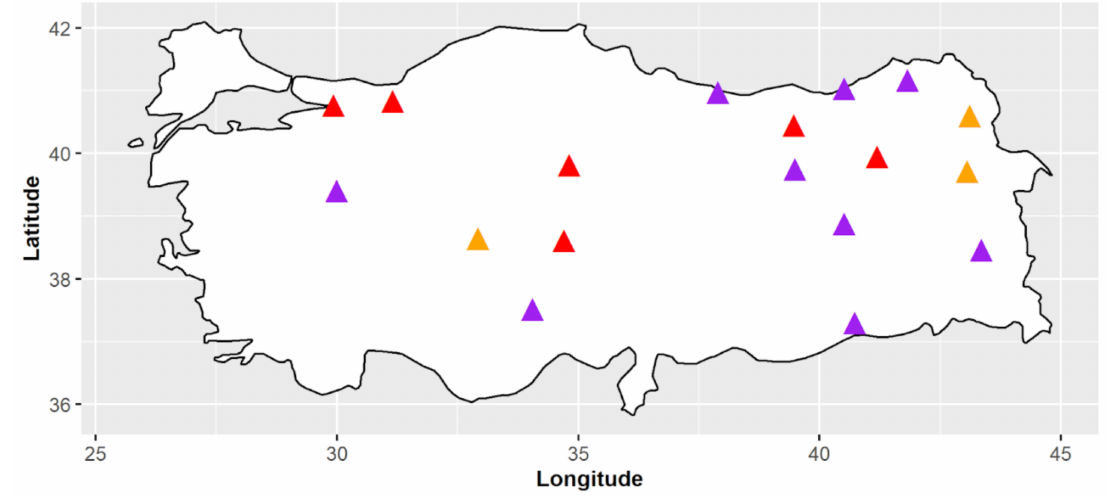
Figure A15. Same as Figure A13 but for February (See Figure A13 for legend).